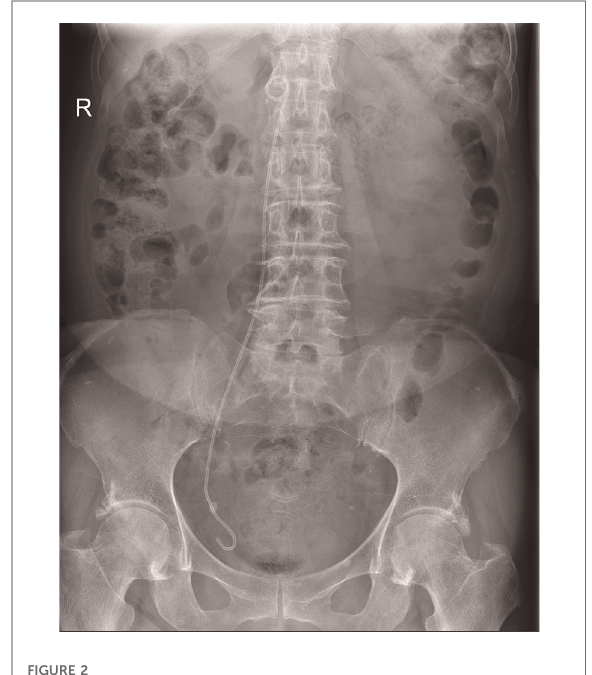
FIGURE 2 X-ray screening of a double J stent (DJS) malposition. The location of the DJS was abnormally closed to the spine.